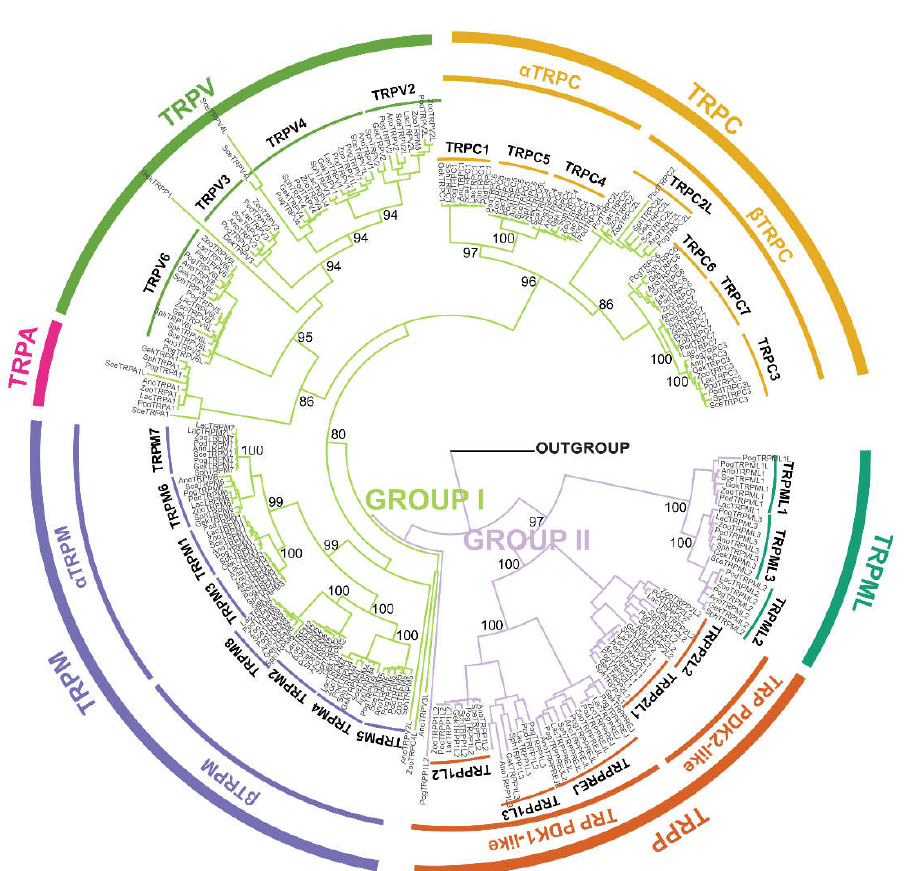
Figure 2. Analysis of the maximum likelihood (ML) tree of TRP s in saurian. Moderate green and grayish violet represent group I and group II, respectively.